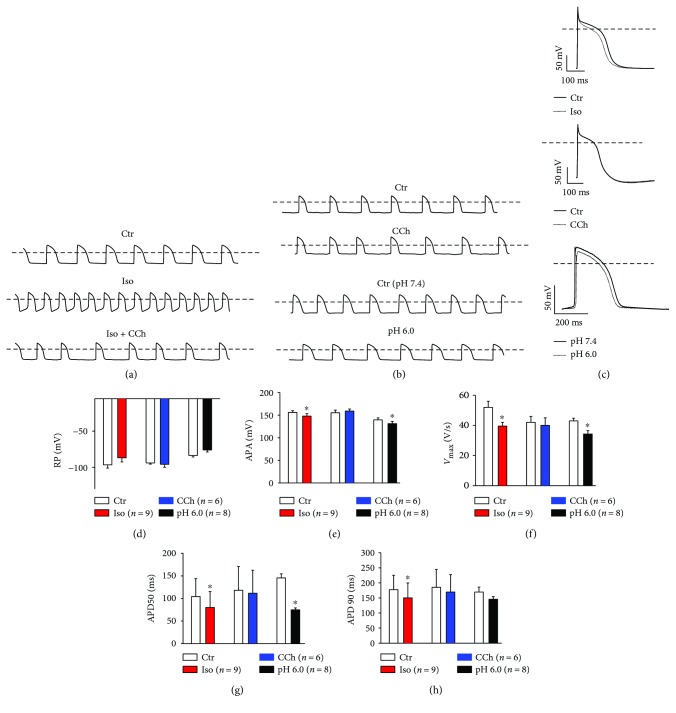
Effects of Iso and CCh as well as of acidosis on APs in hiPSC-CMs. (a) Representative spontaneous APs recorded before (Ctr) and after application of 10 μM Iso and 10 μM Iso + 30 μM CCh. (b) Representative spontaneous APs recorded before (Ctr) and after application of 30 μM CCh or extracellular solution with a pH value of 6.0. (c–h) APs were recorded at a fixed frequency of 1 Hz to analyze the changes of the AP parameters induced by Iso, CCh, and acidosis. Representative traces of APs (c), mean values of resting potential (d), AP amplitude (e), maximal depolarization speed (f), APD50 (g), and APD90 (h) are shown. Values given are mean ± SEM. n: number of cells. ∗
p < 0.05 versus Ctr.